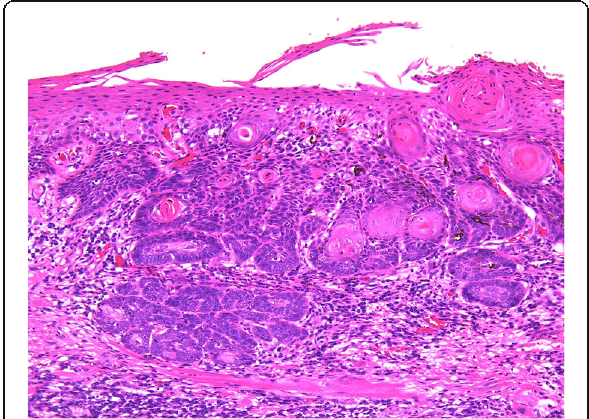
Fig. 1 False-negative representative cases. The deep part of the epithelium reveals downward growth and invasion of tumor cells in the underlying tissue, and surface layer of the epithelium shows keratinocytes without prominent